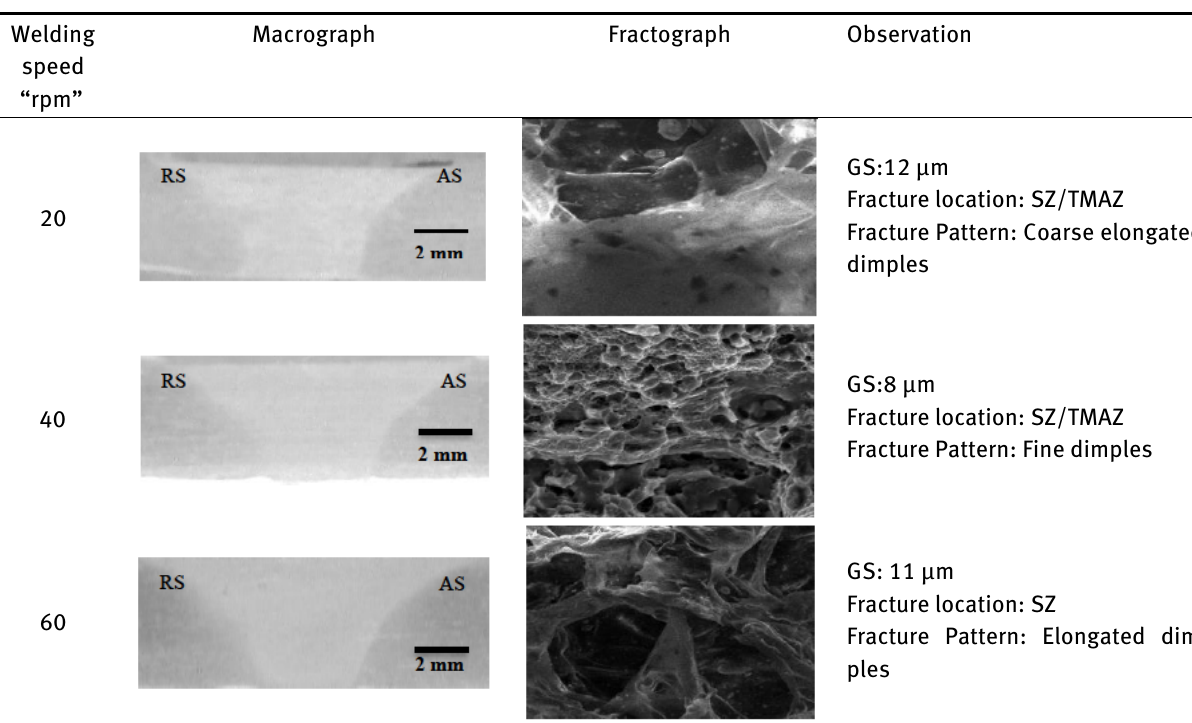
Table 6: Effect of welding speed on macrograph and fracture